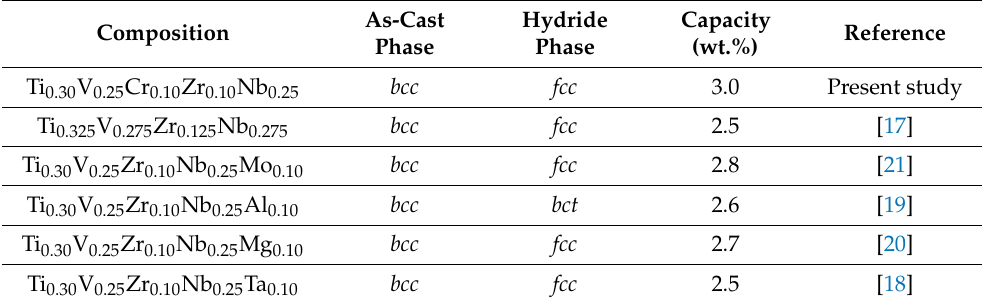
Table 2. Comparison of the hydrogen storage properties of similar HEAs. As-Cast Composition Phase Phase